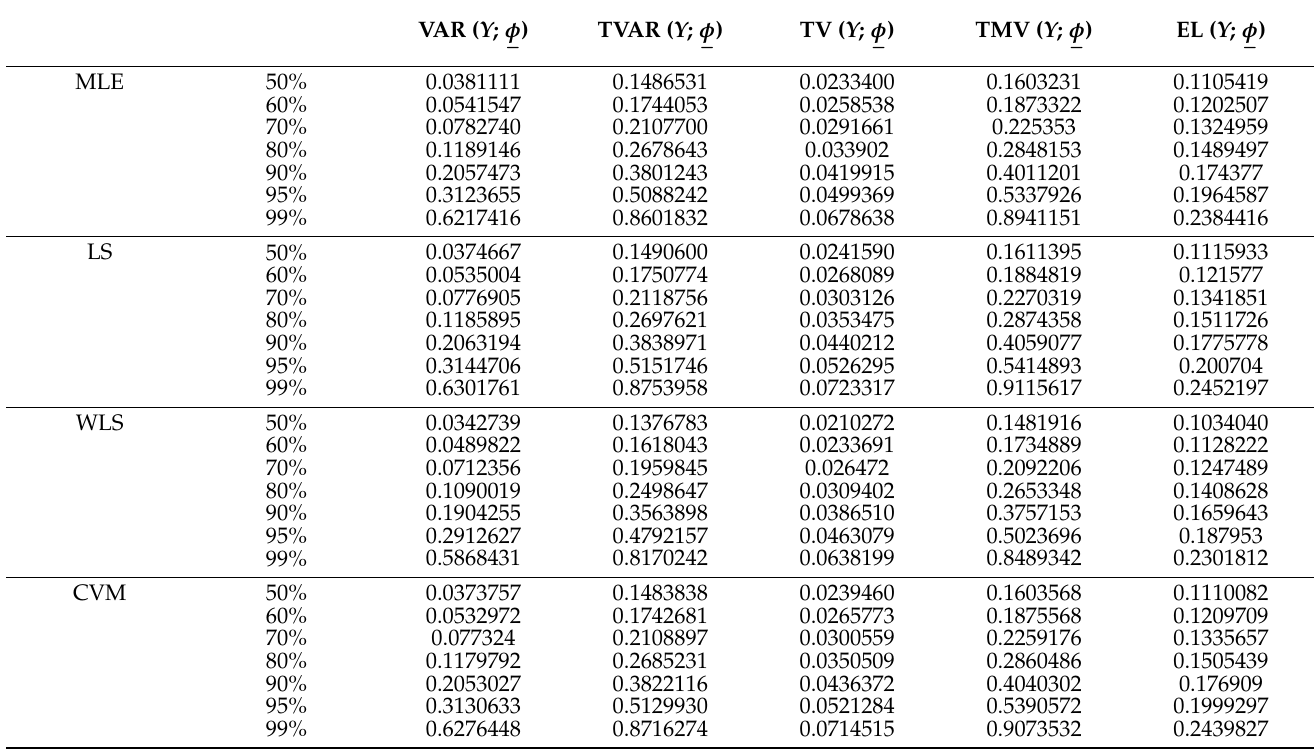
Table 8. The KRIs for the GRR-RW under artificial data where n = 20.